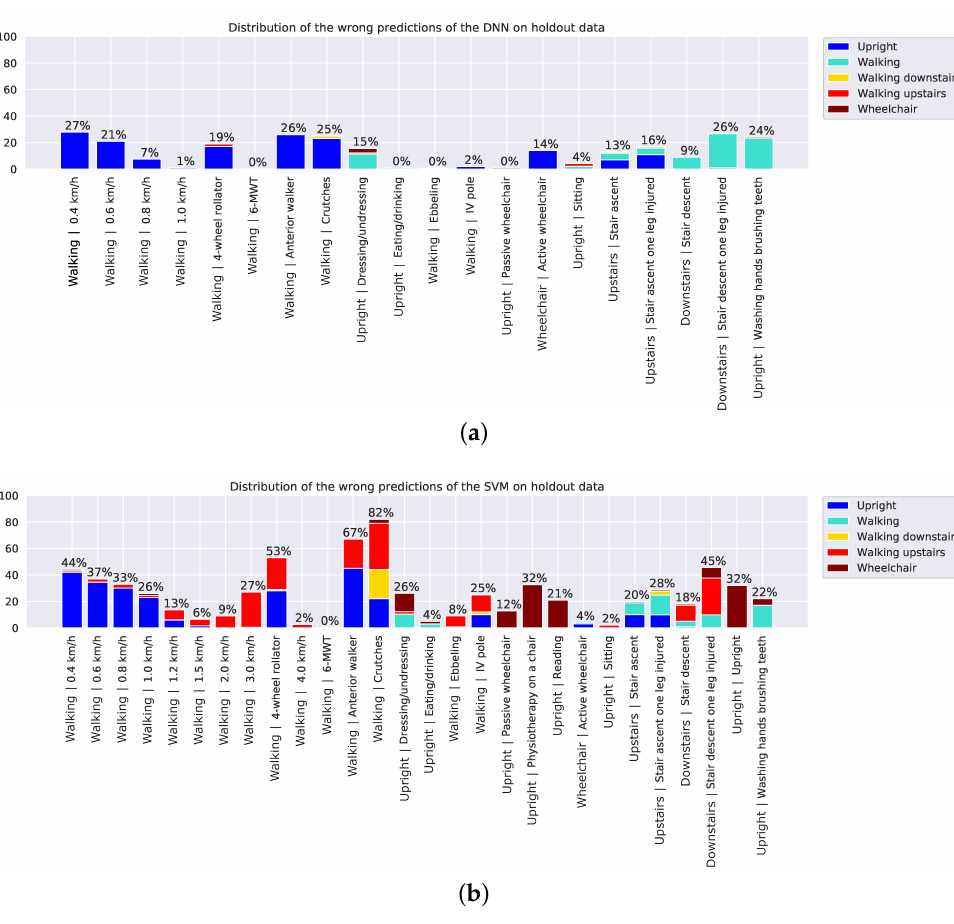
Figure 5. Percentage of wrong predictions per activity by ( a ) the deep neural network (DNN) and ( b ) the support vector machine (SVM). The colors represent the wrongly predicted